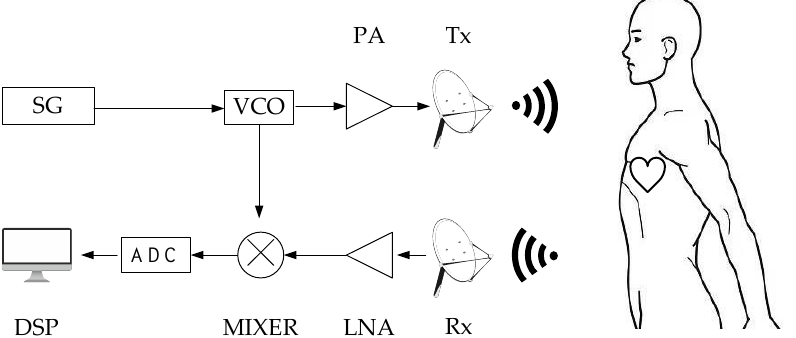
Figure 1. Block diagram of the non-contact FMCW radar. SG: Signal Generator; VCO: Voltage Controlled Oscillator; PA: Power Amplifier; Tx: Transmitting antenna; Rx: Receiving antenna; LNA: Low Noise Amplifier; MIXER: Mixer; ADC: Analog Digital Converter; DSP: Digital Signal Processing.